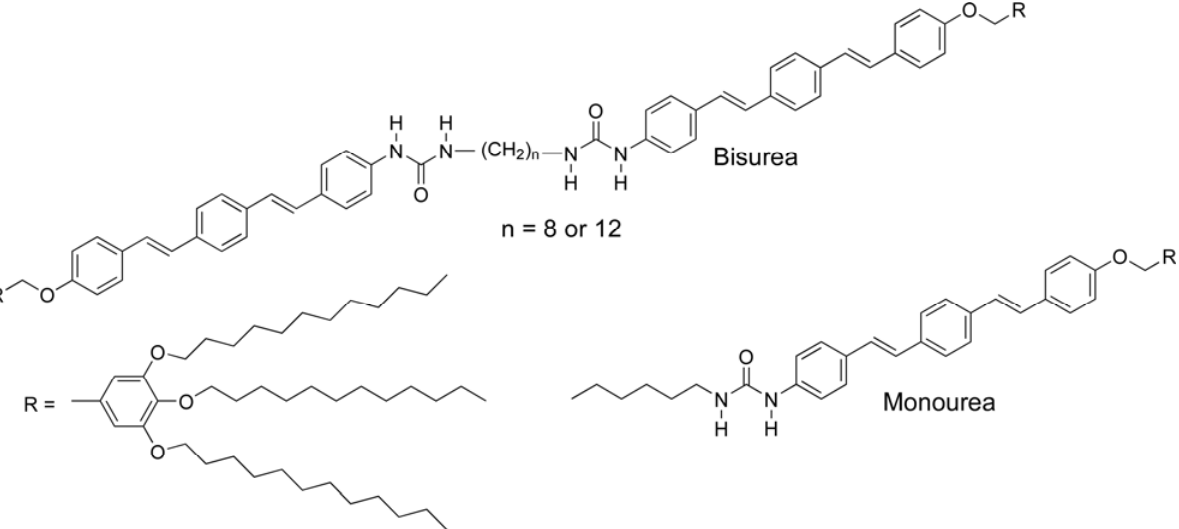
Figure 5. Urea-featuring oligo(p-phenylene